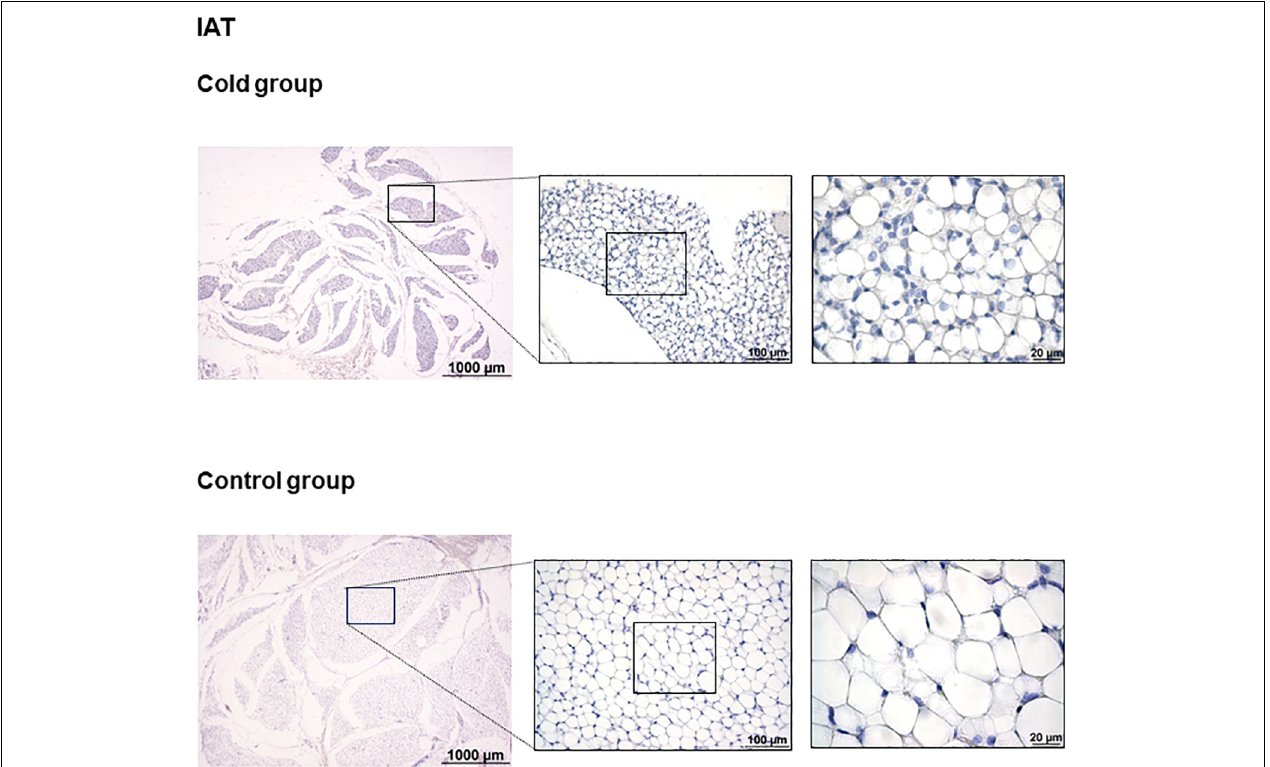
FIGURE 2 | Uncoupling protein 1 immunostaining in IAT of ferrets acclimatized to different room temperatures: 22 ◦ C (control group) or 4 ◦ C (cold group) for 1 week. No appearance of UCP1 positive cells was observed as result of cold exposure. A representative image of an animal of each group is represented. For each image, magnifications of 25 × , 200 × , and 630 × are